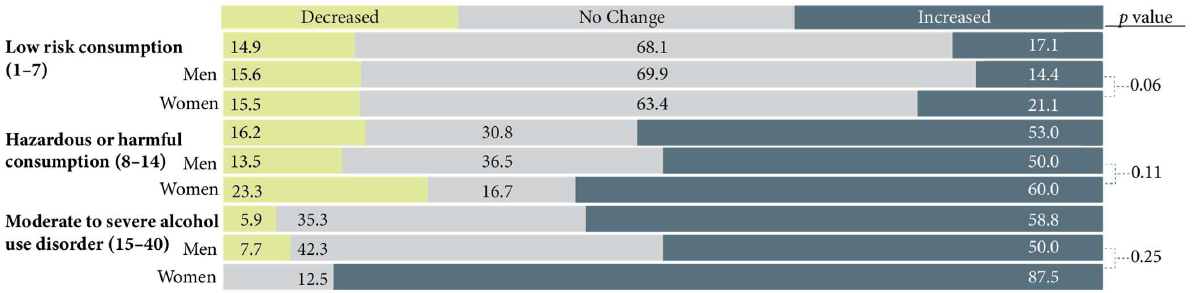
Figure 5. Perceived change in alcohol consumption since the pandemic began by Alcohol Use Disorder Identification Test (AUDIT) classification and by gender.